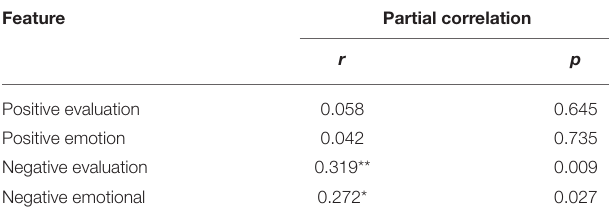
TABLE 2 | Partial correlation analysis of four types of words.